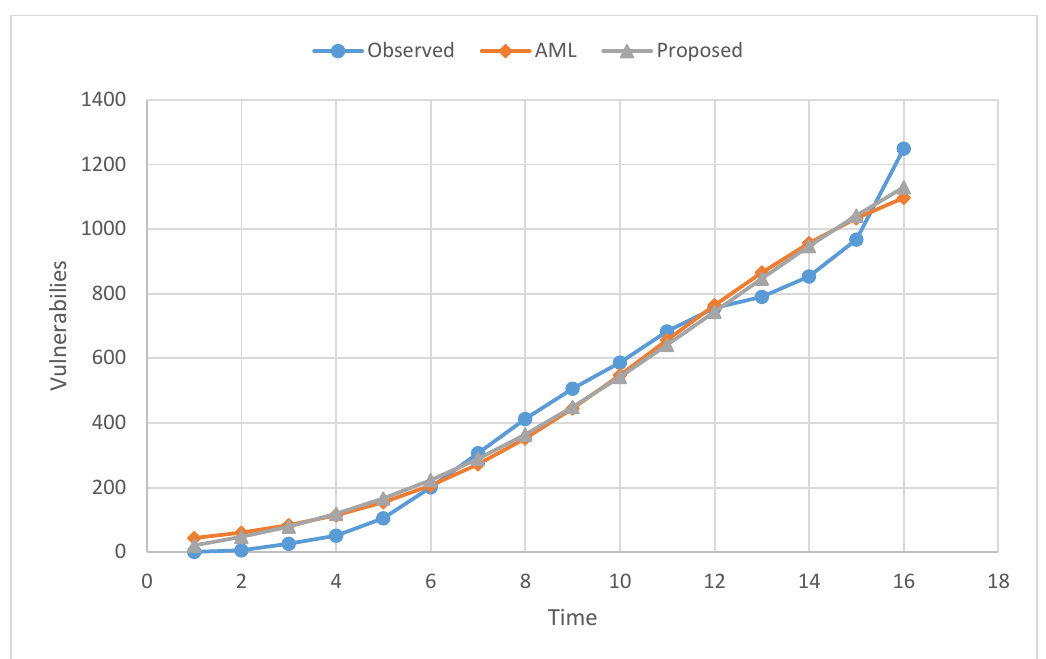
Fig. 5. Goodness of fit curve (Mac OS